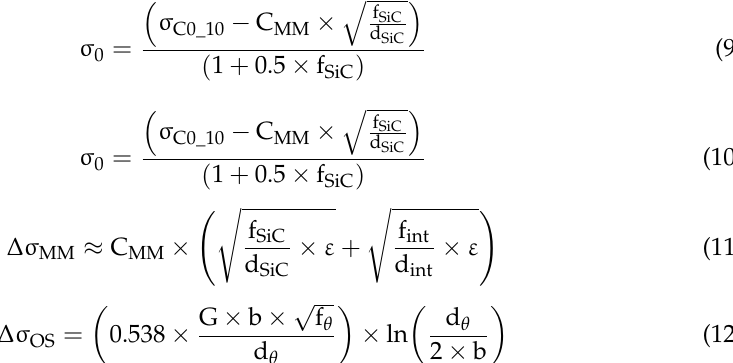
Figure 5. ( a ) The comparison between experimental data and calculated values with Δσ LB and Δσ MM for materials C0_50 and C1_23; ( b ) fitted Feret diameter d θ of θ -Al 2 Cu particles and the resulting Orowan strength contribution Δσ OS . The Thermo-Calc software was used to calculate the volume fraction of precipitates formed in the material C1_23 at test temperature, θ -Al 2 Cu phases were predicted. The